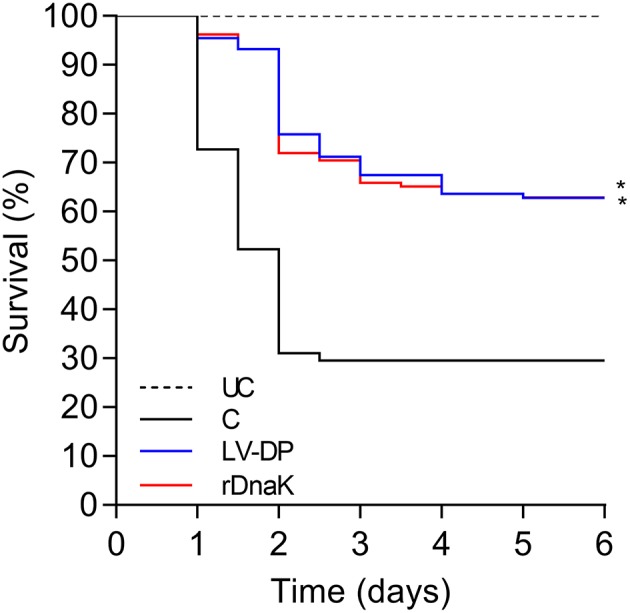
The impact of year-one immunization protocols on the protection of channel catfish against an F. columnare laboratory challenge. Kaplan-Meier survival curves of catfish challenged with isolate LV-359-01 over 6 days. The different groups are labeled as indicated in the figure. Data represent cumulative mortality across three replicate tanks per treatment containing 132 fish (n = 44/tank). Asterisk(s) denote a significant difference in survival when compared to the non-immunized control group; *P < 0.05.